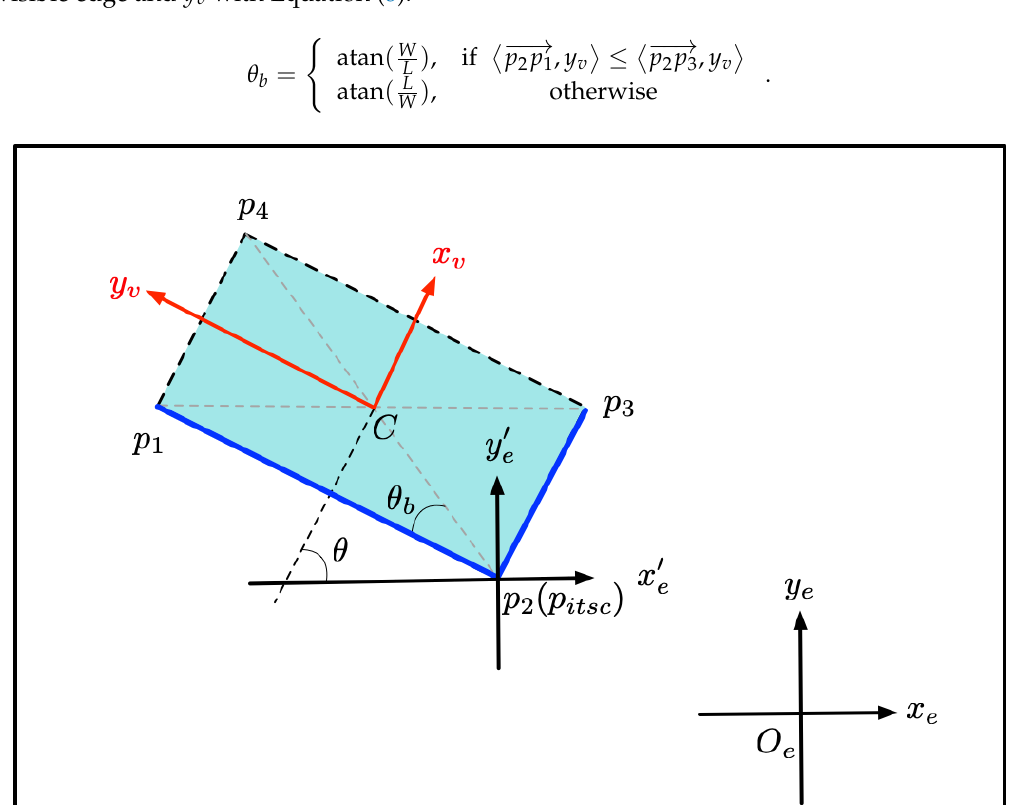
Figure 4. Center-coordinate determination with position inference. Two blue lines, visible edges. x v and y v , two axes of object’s local coordinate system. x e and y e , two axes of global Lidar coordinate system. x (cid:48) e and y (cid:48) e , axes with p itsc as the origin and parallel to x e and y e ,